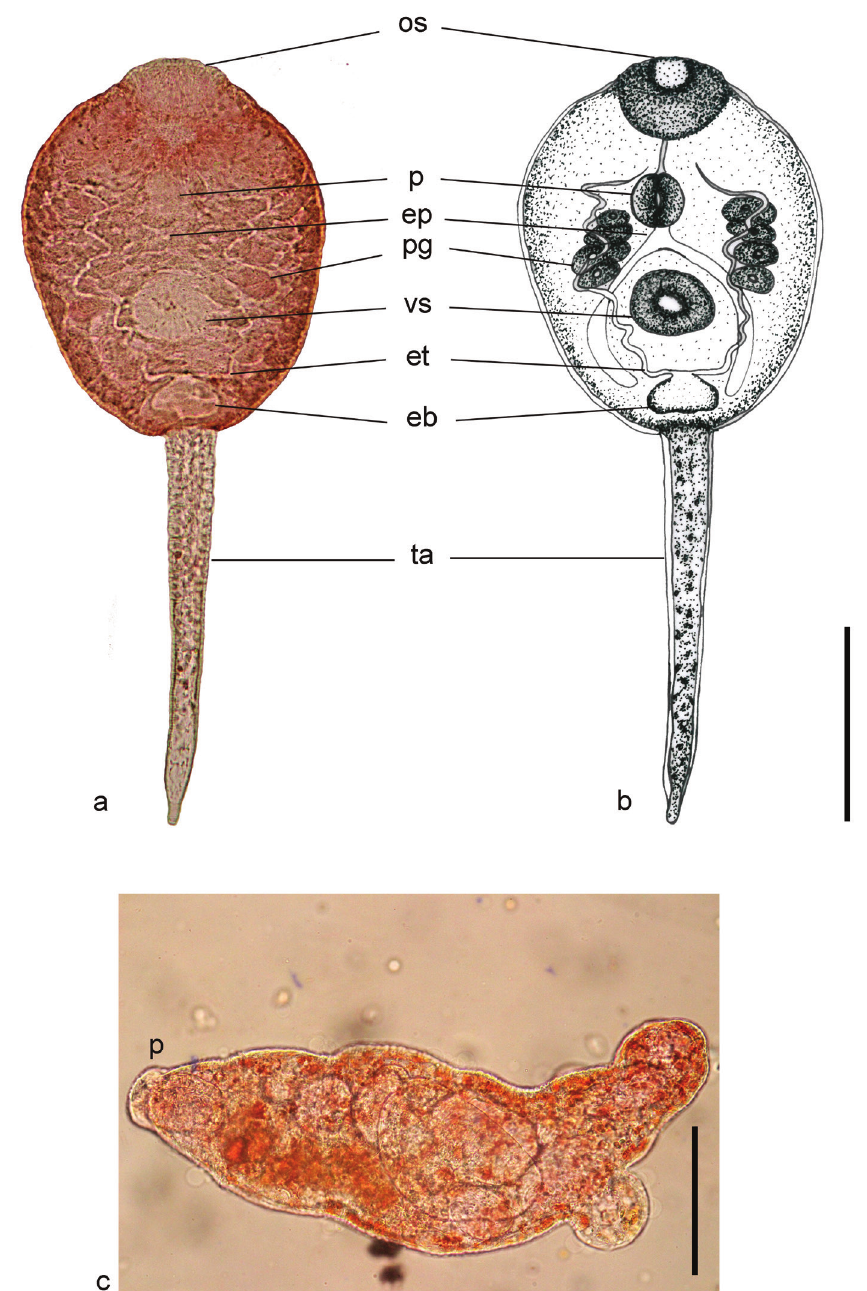
Figure 17. Gymnocephalous cercaria. a . Specimen stained with 0.5% neutral red. b . Drawing of cercaria. c . Redia stained with 0.5% neutral red. Abbreviations – eb: excretory bladder; ep: esophagus; et: excretory tubule; os: oral sucker; p: pharynx; pg: penetration gland; ta: tail; vs: ventral sucker. Scale bars: 50